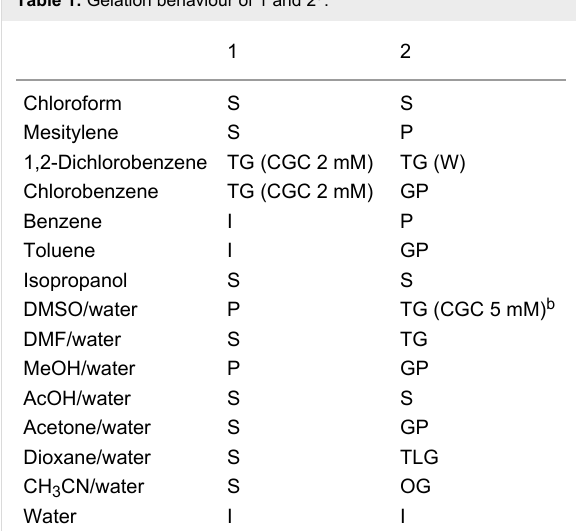
Table 1: Gelation behaviour of 1 and 2 a